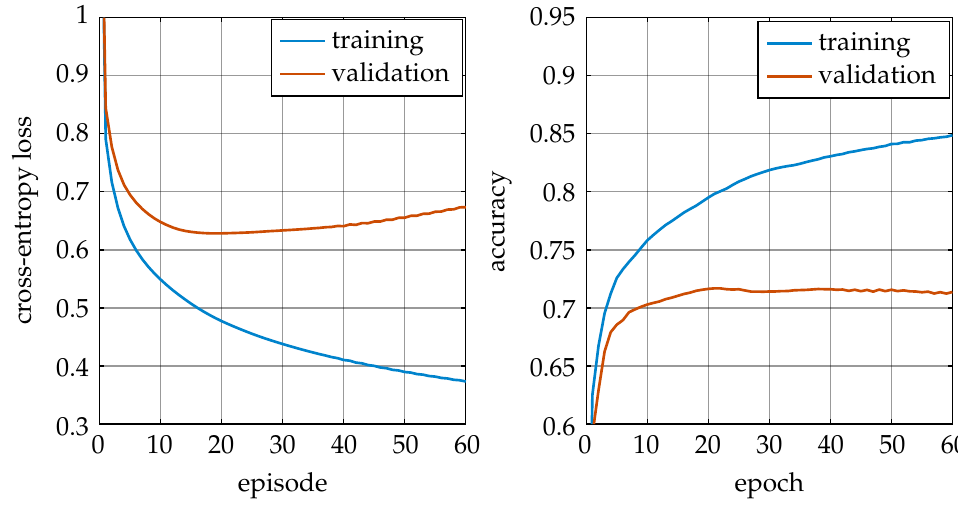
Figure 3. Pretraining metrics.